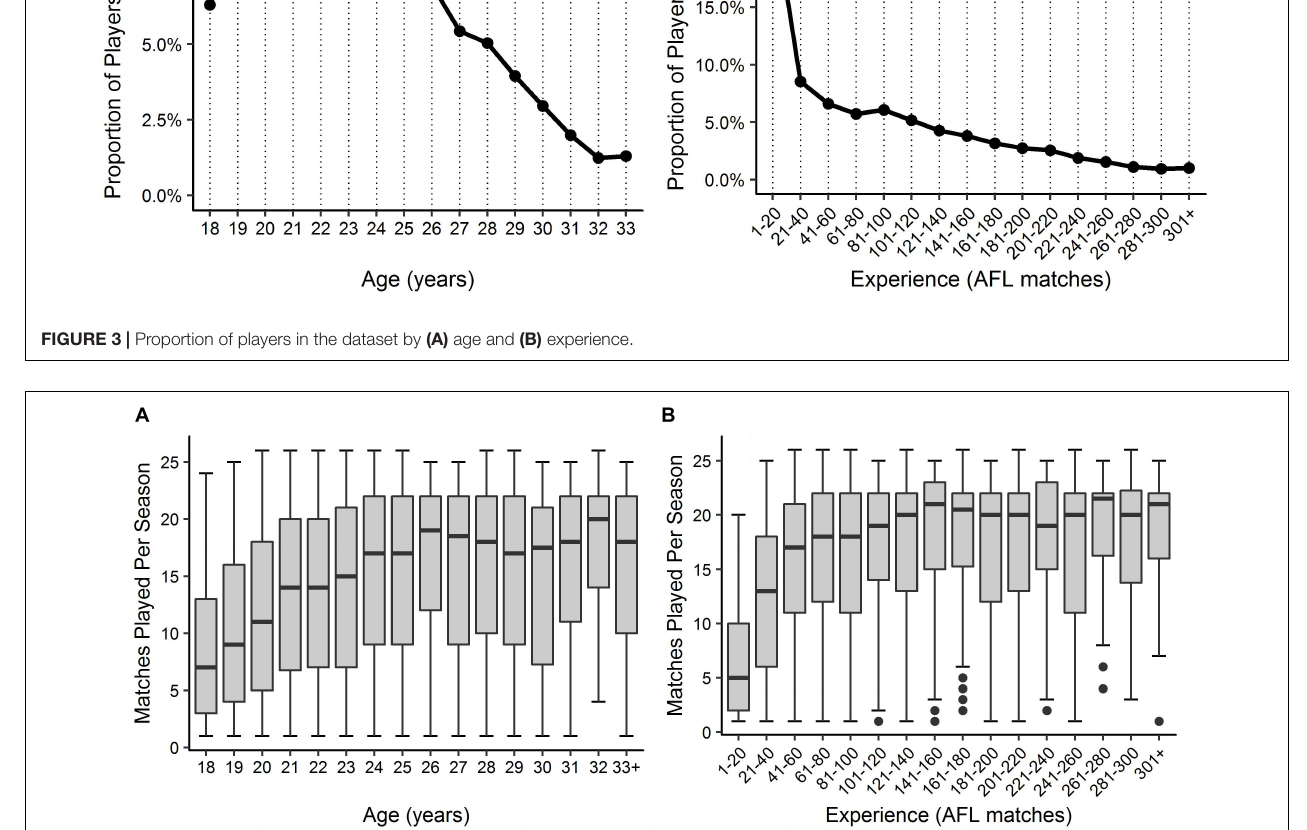
FIGURE 4 | Boxplot outlining the distribution of matches played per season by players in each level of (A) age and (B) experience.